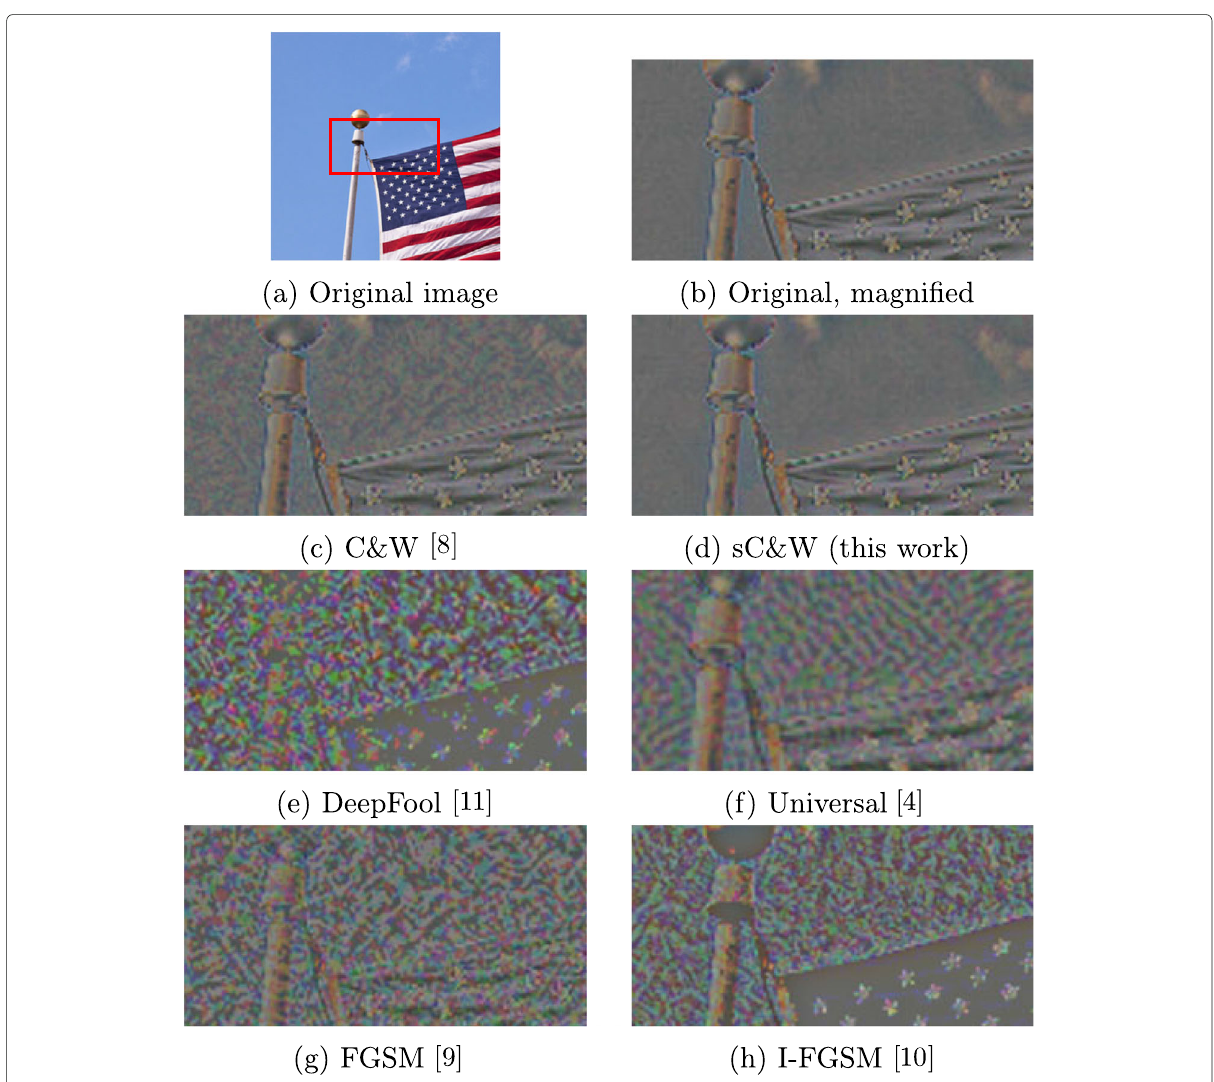
Fig. 1 Given a single input image, our adversarialmagnification ( cf Appendix 1) reveals the effect of a potential adversarial perturbation. We show a the original image followed by b its own magnified version as well as c – h magnified versions of adversarial examples generated by different attacks. Our smoothadversarialexample ( d ) is invisible even when magnified